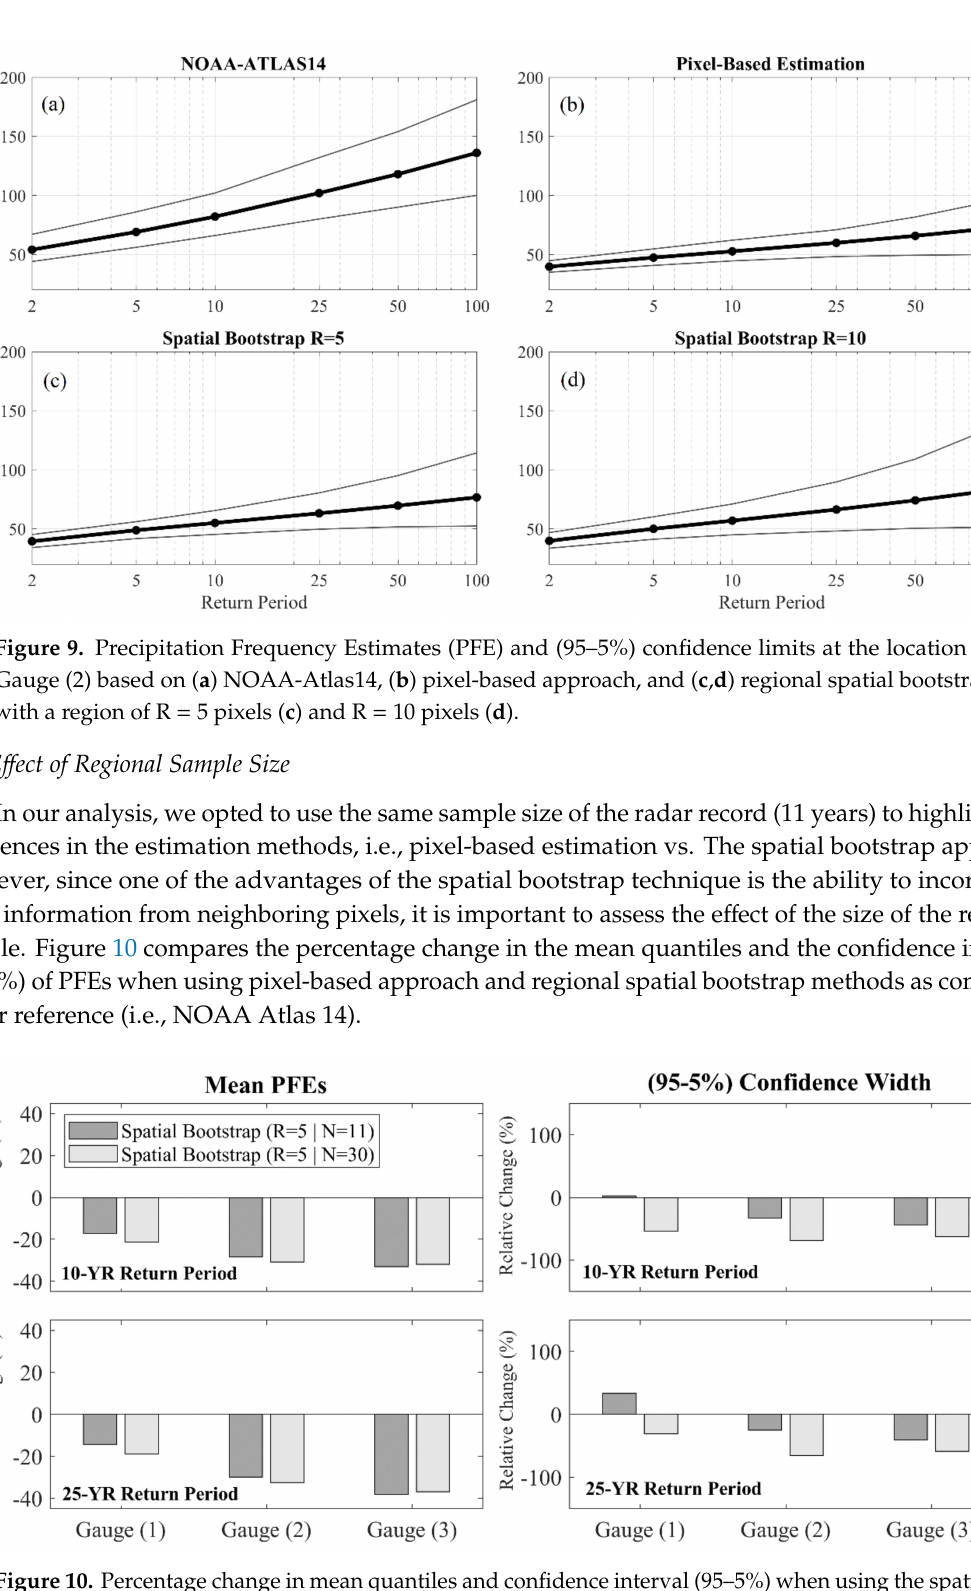
Figure 10. Percentage change in mean quantiles and confidence interval (95–5%) when using the spatial bootstrap method with sample size of 11 and 30, compared to NOAA Atlas 14 gauge-based PFES (only 10 and 25-year return periods are